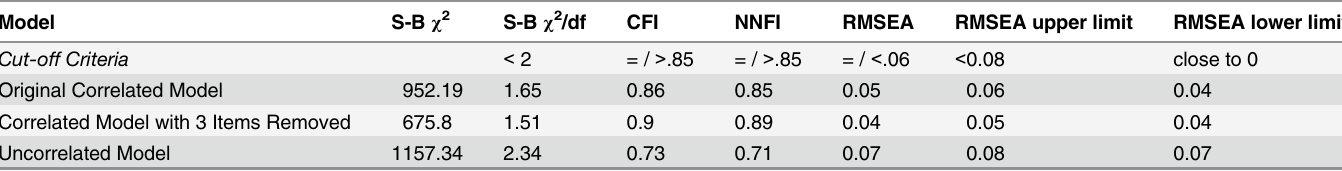
Table 3. Comparison of Correlated and Uncorrelated CFA